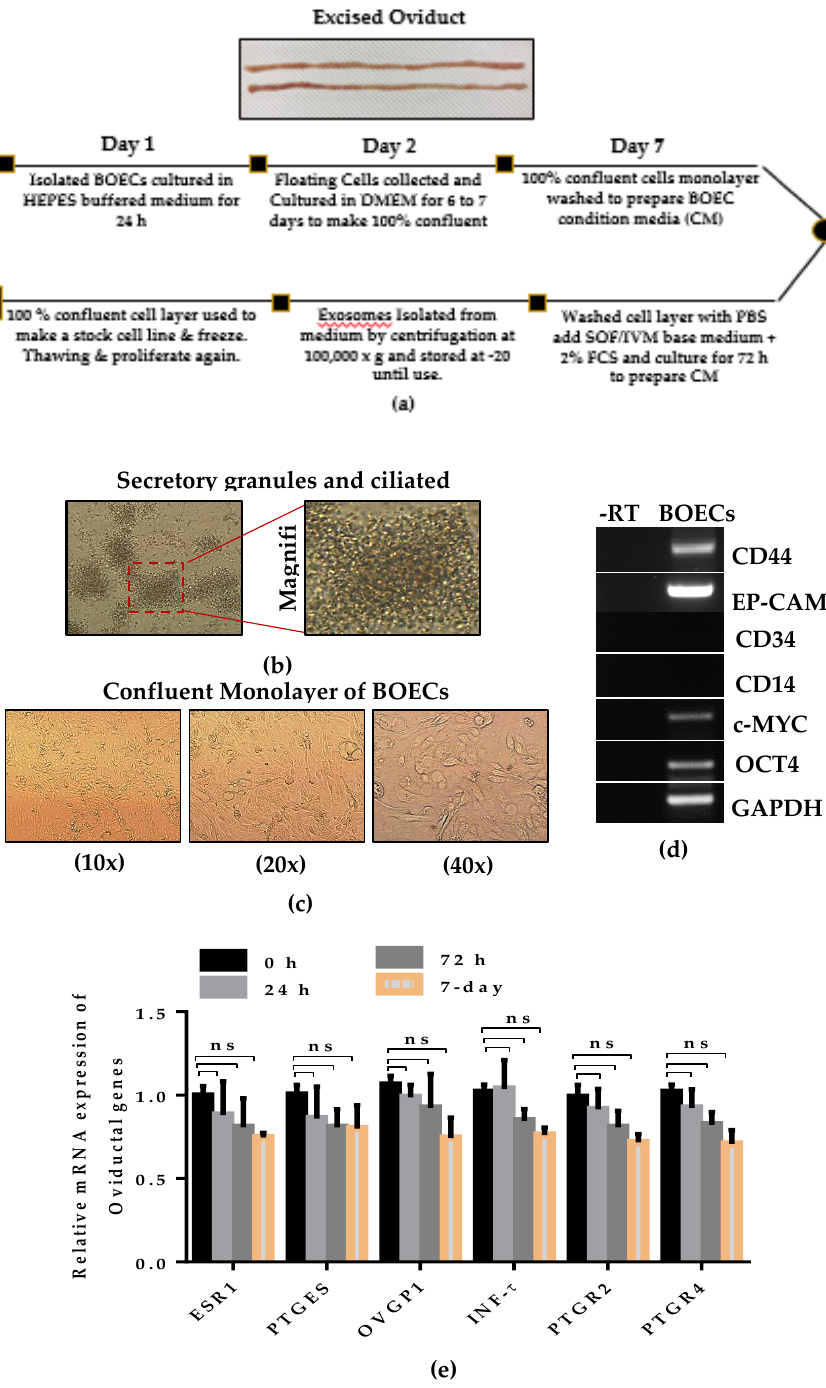
Figure 1. Morphology and characterization of bovine oviduct epithelial cells (BOECs). ( a ) Schematic flow diagram of BOECs isolation and culture. ( b ) Aggregated ciliated cells after 24 h culture, with the intense appearance of beating cilia like structure on the cell surface. ( c ) Isolated BOECs-monolayer showing typical epithelial morphology after several days of culture. ( d ) RT-PCR displaying the presence of characteristics epithelial and cell proliferative marker and the absence of hematopoietic (CD34 and CD14) markers from cell culture. ( e ) qRT-PCR analysis of the expression profile of several oviduct marker genes in cultured BOEC monolayer at 0, 24, 72 h and seven days of cell seeding. Data are presented as a result of ± SEM (standard error of mean) of four replicates. ns, indicates non-significant di ff